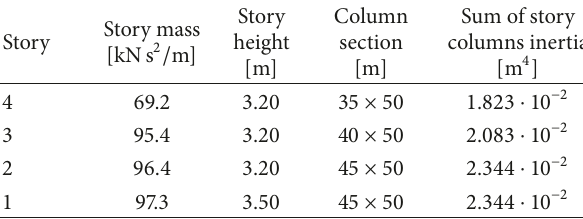
Table 1: Geometric data of the analyzed shear-type